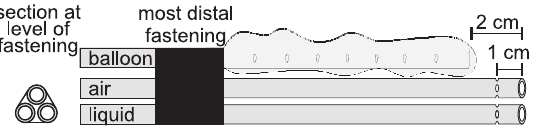
Figure 1. Illustration of the combination of catheters used for the experiment. The catheters were permanently fastened together, with the tip of the air- and liquid-filled catheters positioned 2 cm further down the esophagus than the tip of the balloon. Additional 4 holes were created in the liquid- and air-filled catheters to minimize the possibility of obstruction, located equidistantly along the circumference of the catheter at approximately 1 cm from the tip.